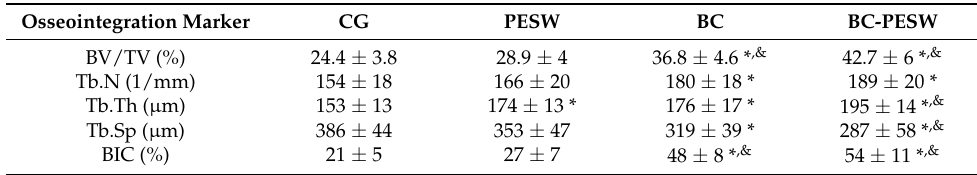
Table 2. Quantitative results of the implant osseointegration, as assessed using micro-CT; * p < 0.05 vs. CG; & p < 0.05 vs PESW. The bone volume per total volume (BV/TV), the mean trabecular number (Tb.N), the mean trabecular thickness (Tb.Th), the mean trabecular separation (Tb.Sp) and bone-to-implant contact (BIC) are given for the four animal groups. Osseointegration Marker CG PESW BC BC-PESW BV/TV